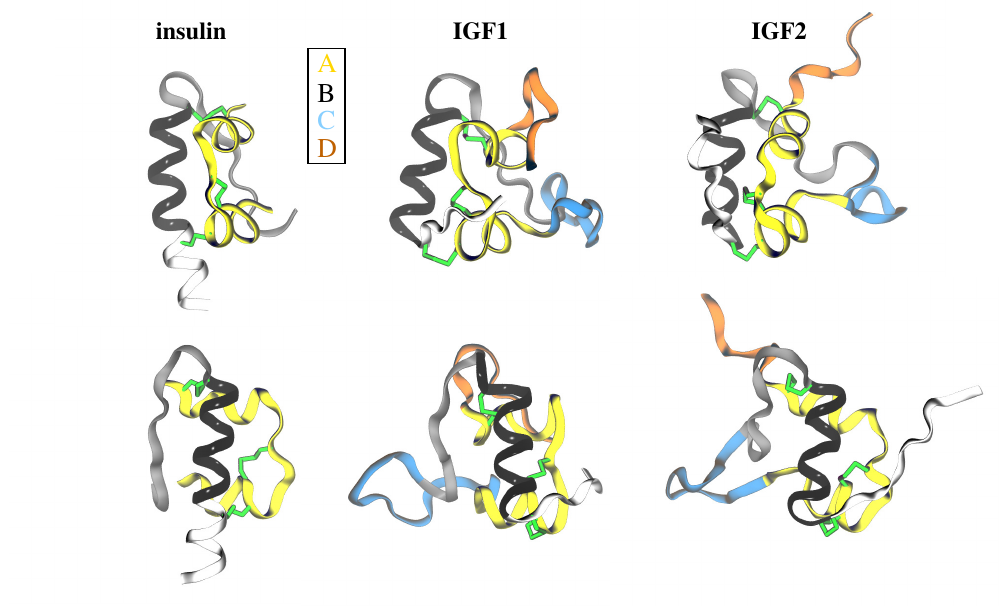
Figure 1. Cartoon representations of the three-dimensional folds of insulin, IGF1 and IGF2: A chains/domains are yellow; C and D domains are blue and orange; while parts of B chains/domains are shown in white (N-terminus), black (middle helix) and gray (C-terminus). Disulfide bonds are represented by greens sticks. ( top ) Side views focusing simultaneously on A and B chains/domains; ( bottom ) views focusing on the B chains/domains with other parts of ligands hidden